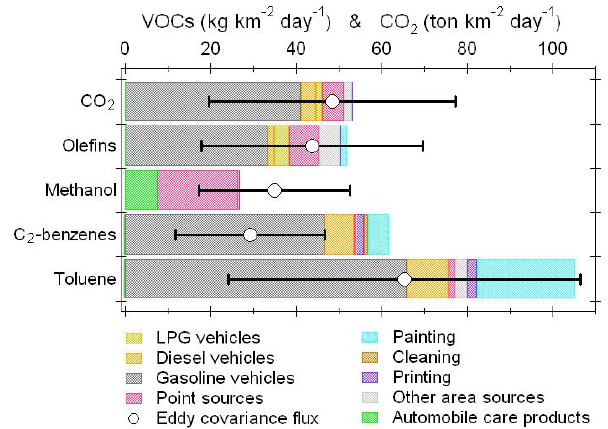
Fig. 8. Total daily measured fluxes at the SIMAT site compared to the disaggregated emissions by source type in the official 2006 emissions inventory. The emission profiles of CO 2 and 4 VOCs are included (provided by E. Velasco,